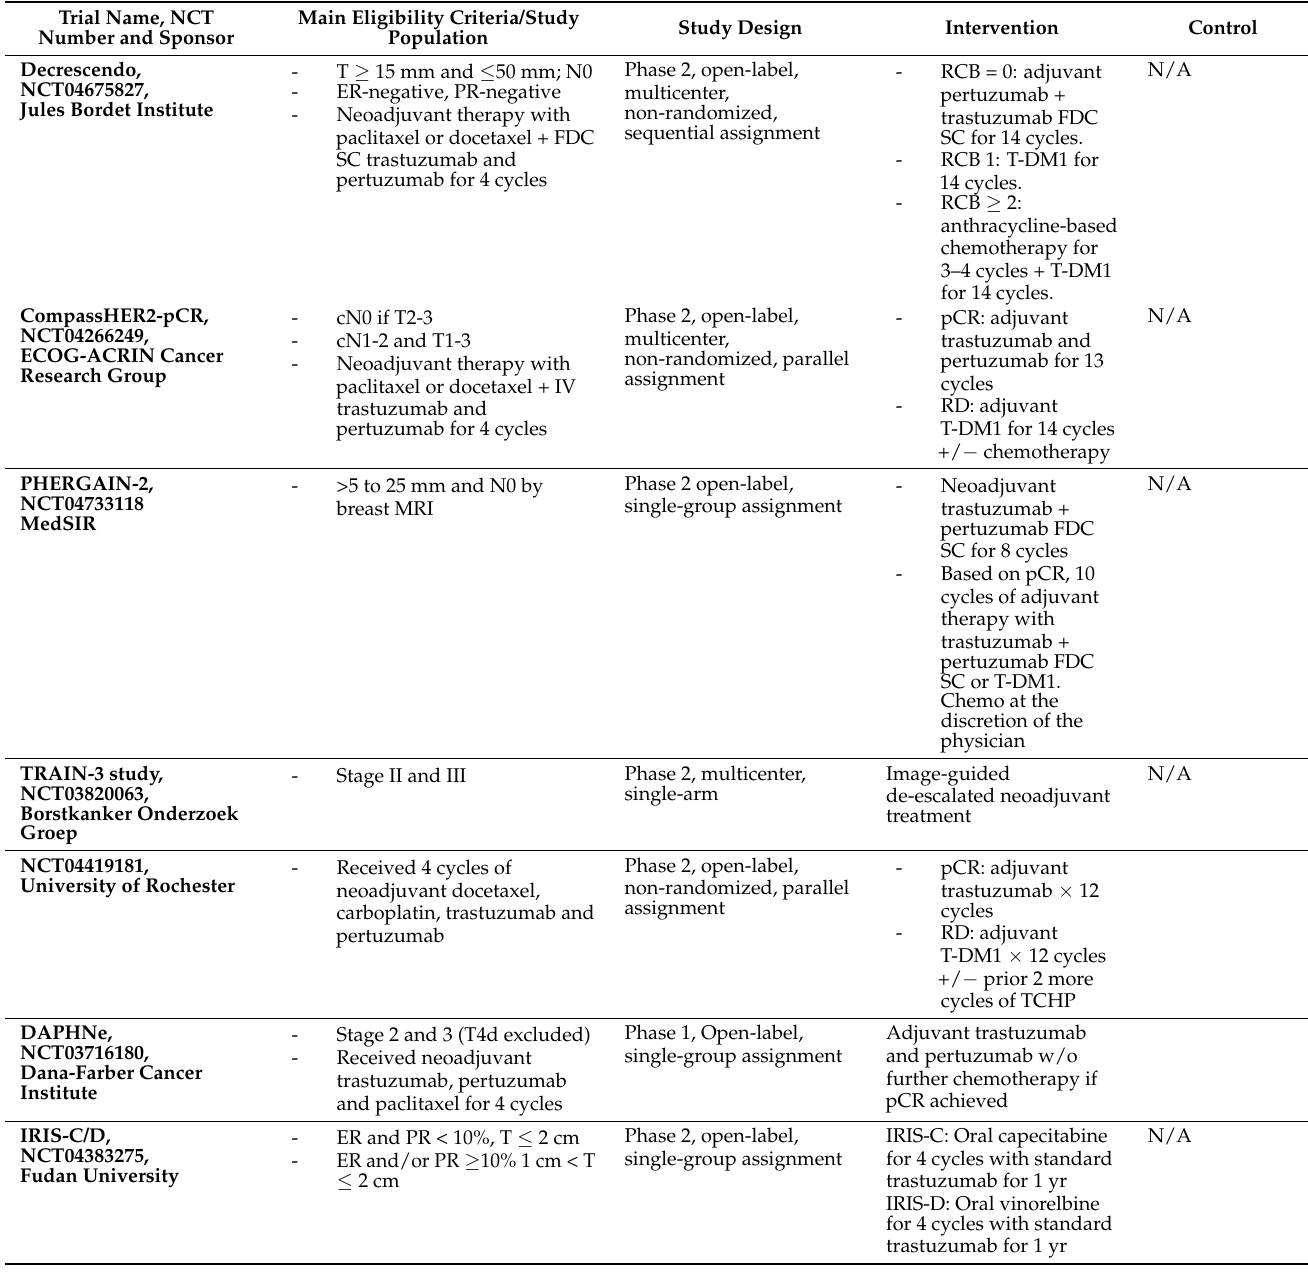
Table 1. Ongoing active de-escalation studies for curative treatment of HER2-positive breast